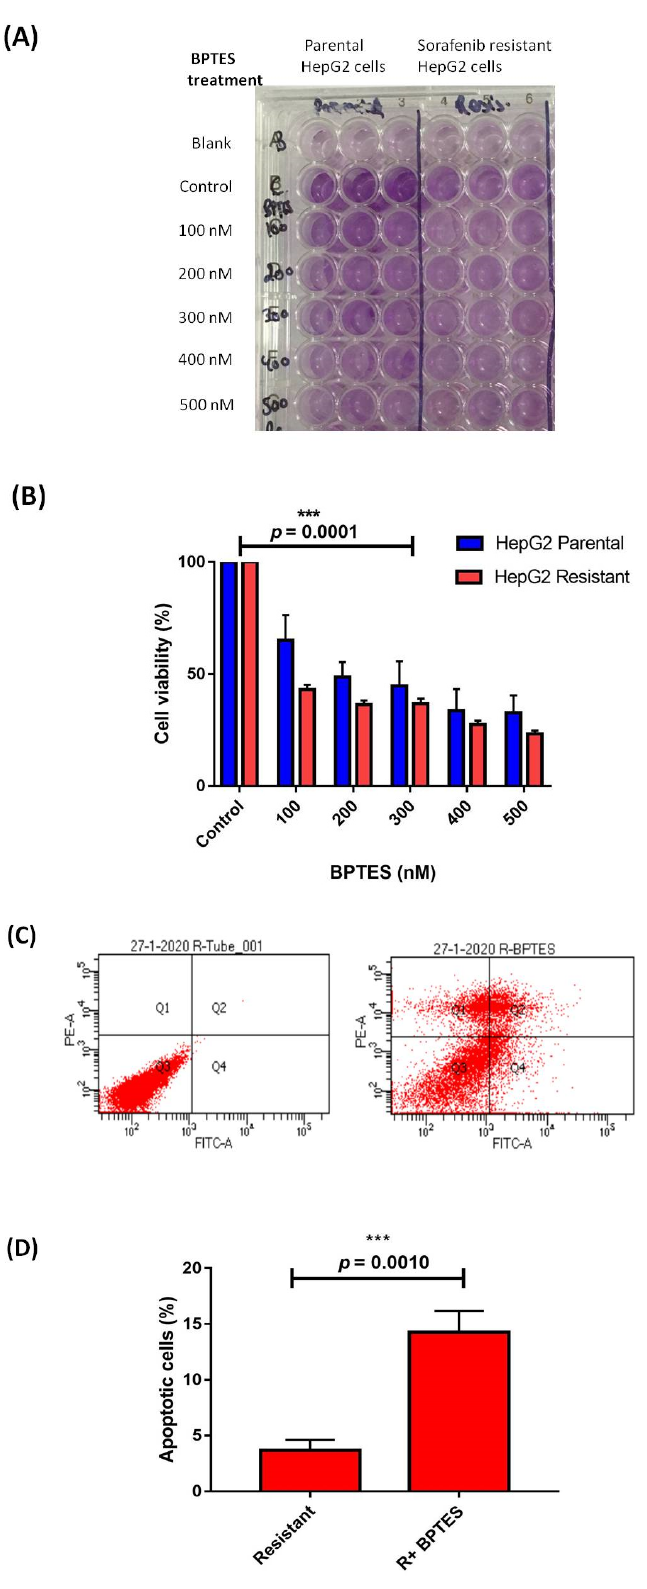
Figure 6. The cell viability (%) in parental and sorafenib resistant HepG2 cells by MTT assay